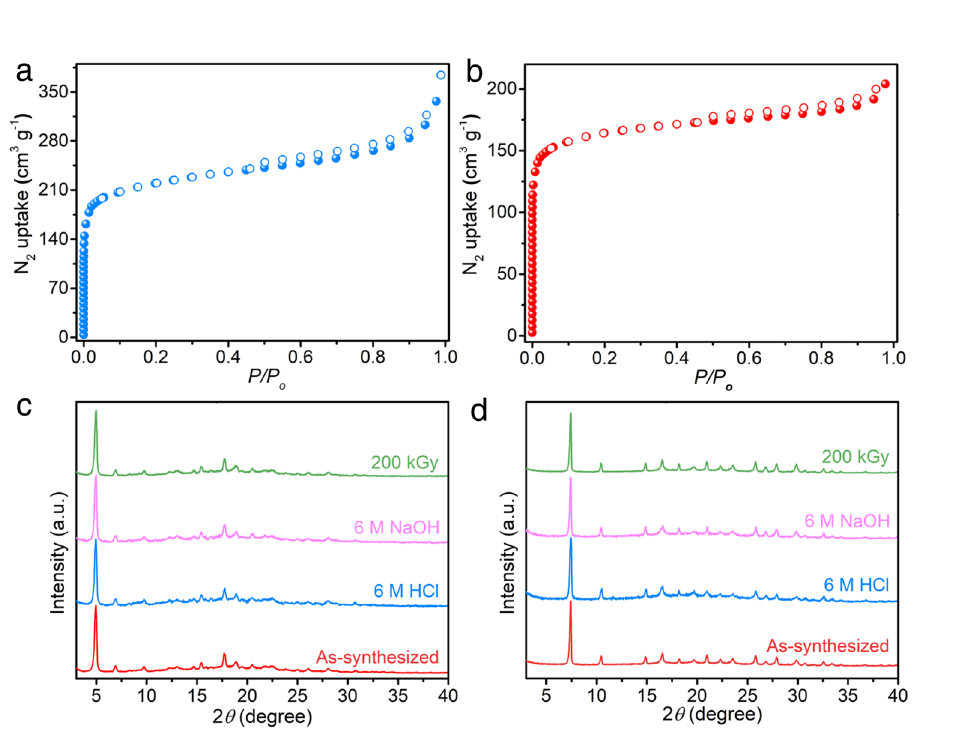
Fig. 3 | Characterization and stability of 3D sp 2 carbon-linked COFs. N 2 adsorption-desorption isotherms for ( a ) TAPM-PZI and ( b ) TFPM-PZI. PXRD patterns of ( c ) TAPM-PZI and ( d ) TFPM-PZI before and after treatment with 200kGy γ -ray irradiation, 6M NaOH, 6M HCl for 48h.